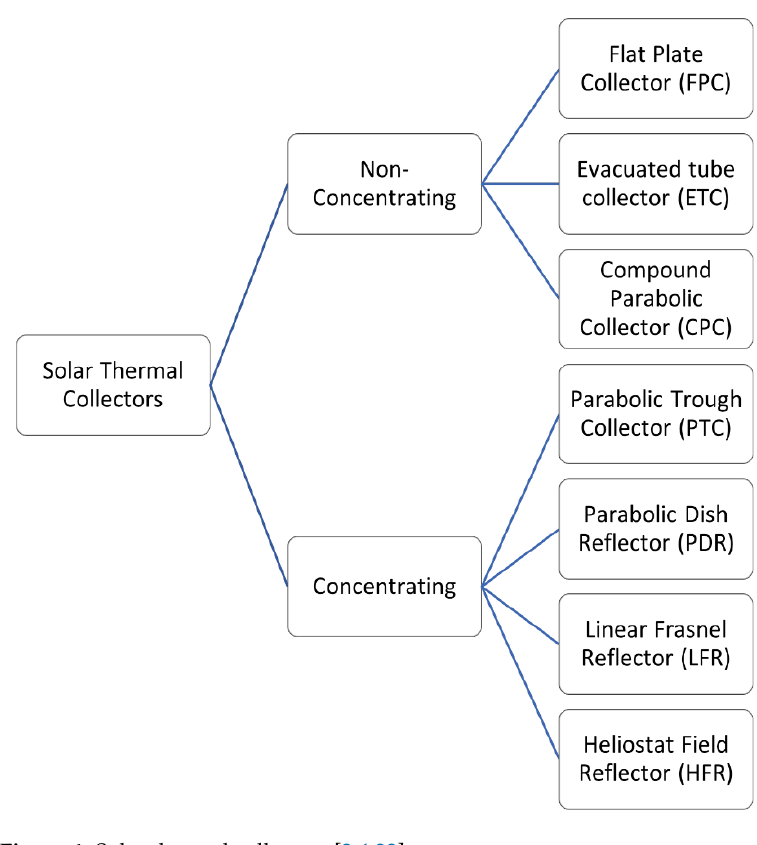
Figure 4. Solar thermal collectors [2,4,33]